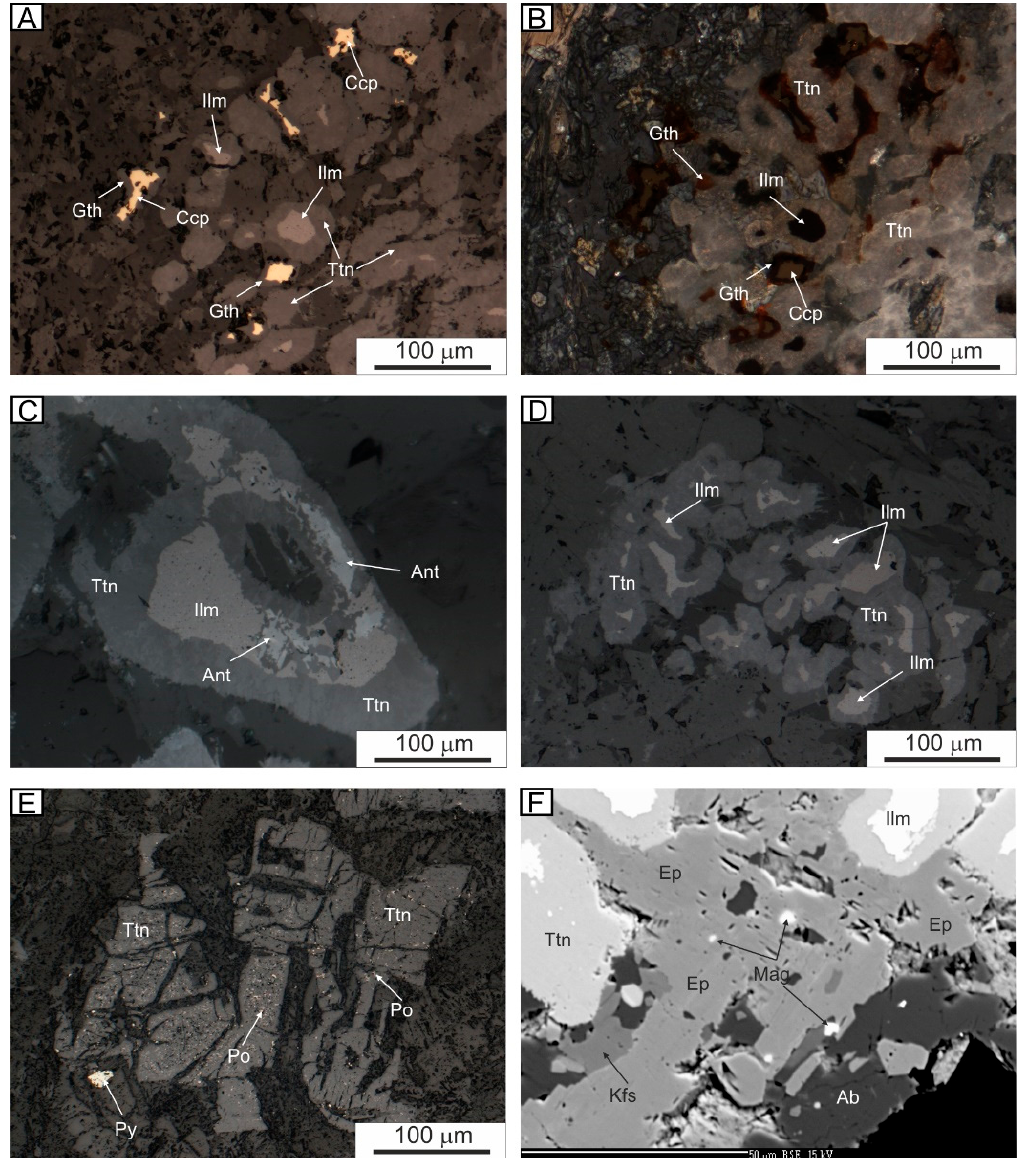
Figure 4. Fe-Ti oxides within the metadolerites. ( A , B ) Ilmenite and chalcopyrite intergrowths partly replaced by metamorphic titanite and goethite, respectively. ( A ) Sample Dau0109 (site DAUST1), parallel nicols; ( B ) from the same sample, crossed nicols; ( C ) Relic of ilmenite surrounded by younger titanite and anatase. Sample Dau-1219 (site DAUST2), parallel nicols; ( D ) Metamorphic titanite growing around ilmenite. Sample Dau5304 (site DAUST5), parallel nicols; ( E ) Titanite pseudomorph after Ti-magnetite (magmatic in origin). Within titanite numerous irregular inclusions of metamorphic pyrrhotite. Sample Dau5607 (site DAUST5), parallel nicols; ( F ) BSE image showing small euhedral magnetite crystals within epidote. Ilmenite surrounded by titanite, small intergrowths of albite and K-feldspars. Sample Dau14 (site DAUST2). Abbreviations: Ab—albite, Ant—anatase,